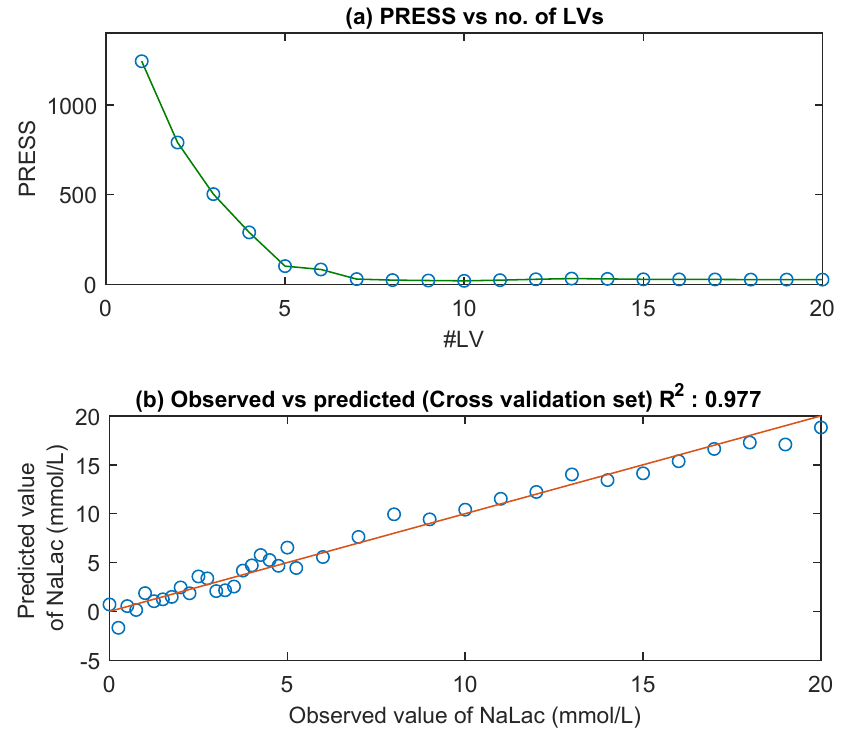
Figure 5. ( a ) The graph of PRESS versus number of latent variables (LV) for NIR spectra. Optimal number of LVs used for building the PLS model were eight, and ( b ) predicted NaLac concentration vs. the reference NaLac concentration of thirty-seven PBS samples. The correlation coefficient (R 2 ) and root mean square error of cross-validation (RMSECV) were 0.977 and 0.89 mmol/L,